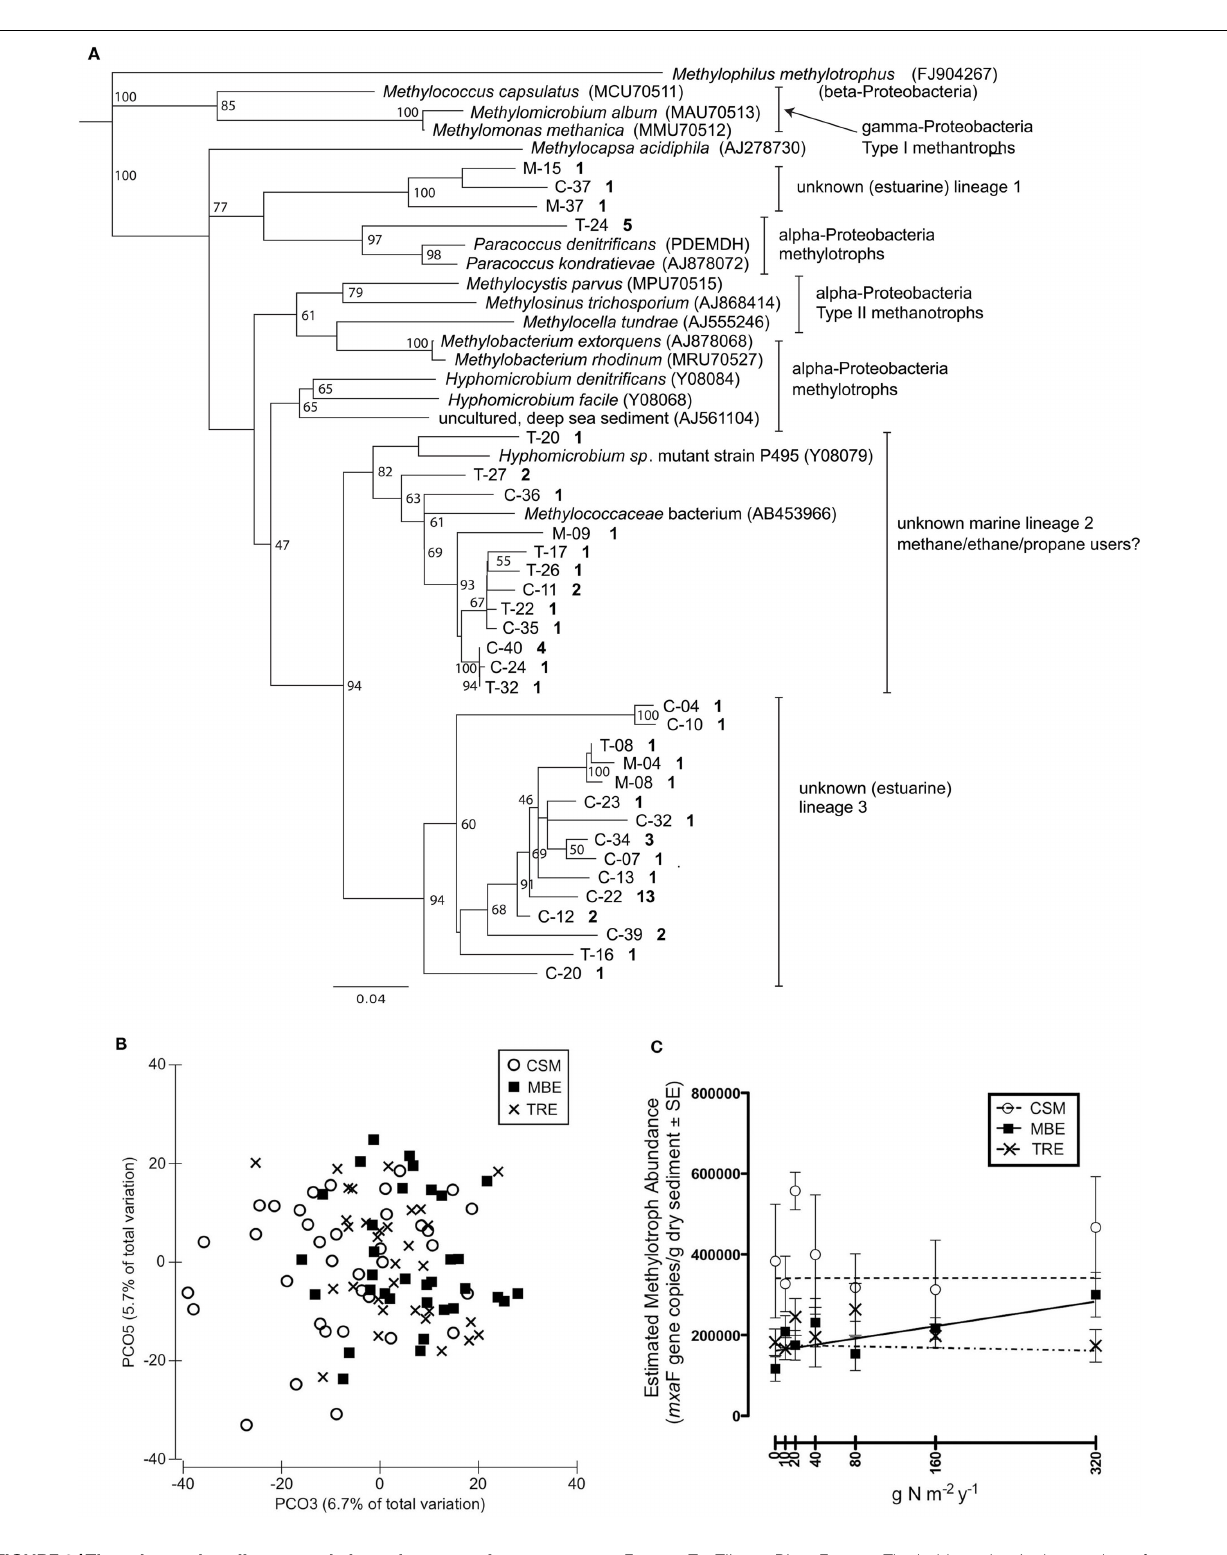
FIGURE 3 |The salt marsh sediment methylotroph community as assayed by the methanol dehydrogenase functional gene ( mxa F). (A) Neighbor-joining tree of representative OTUs ( ≥ 99% similar) based on nucleotide mxaF sequences.The OTUs are designated by marsh and sequence number, where C = Carpinteria Salt Marsh, M = Morro Bay